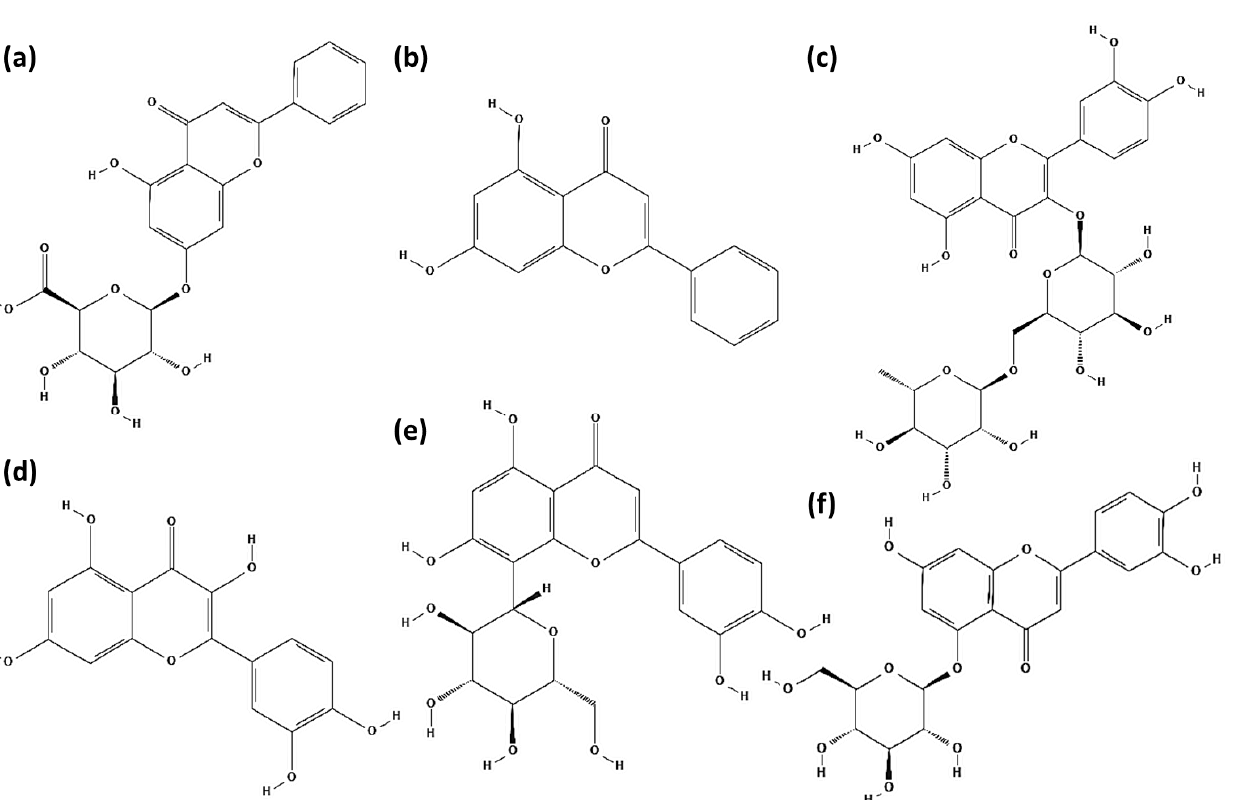
Figure 1. Some examples of C. multiflorus in the Beira Interior region (Portugal); ( A ) branches and flowers of the shrub; ( B ) its characteristic flower; ( C ) a complete shrub.